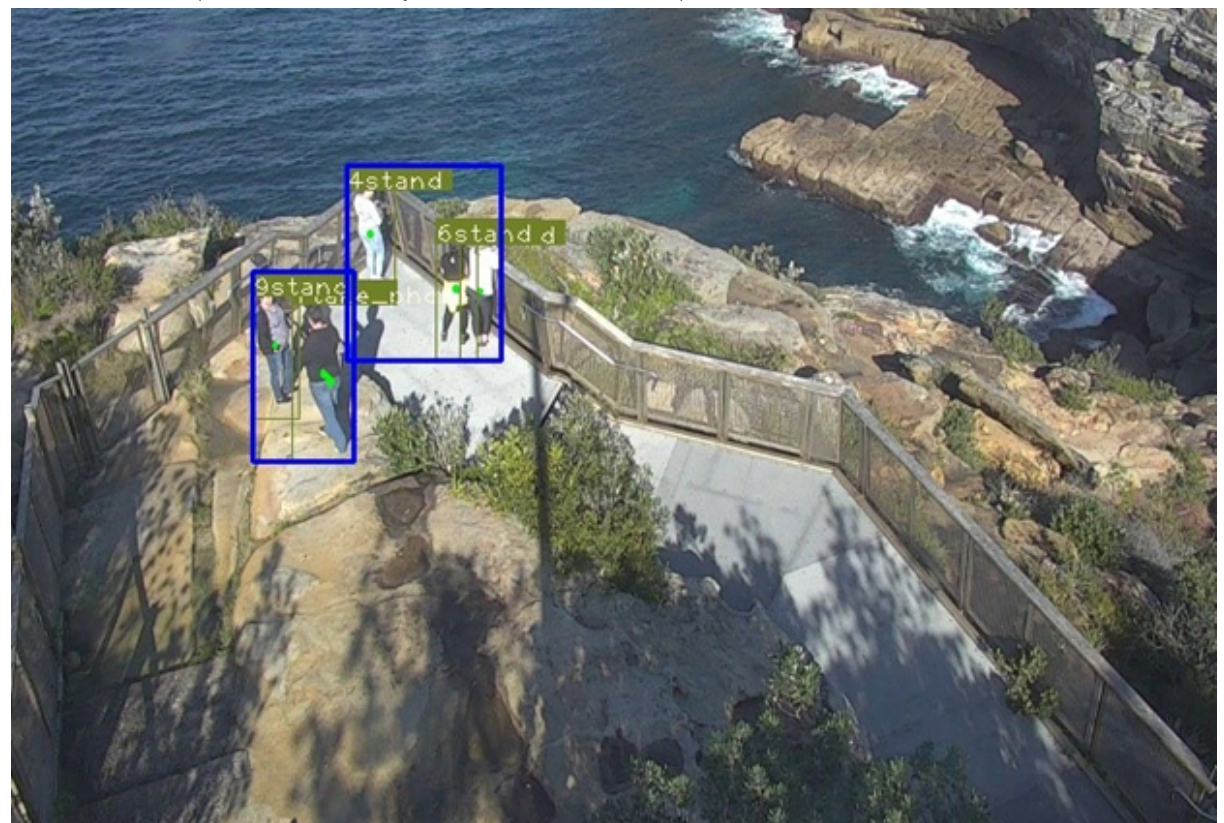
Figure 9. Example Output of the Analysis Pipeline 2. In this frame, five pedestrians within two groups have been identified. Their actions have been identified, with four individuals standing (“stand”) and one individual taking a photo (“take photo”). Their trajectories (in the form of dots and short lines at the centre of each person) indicate that they have remained in their current positions for the recent